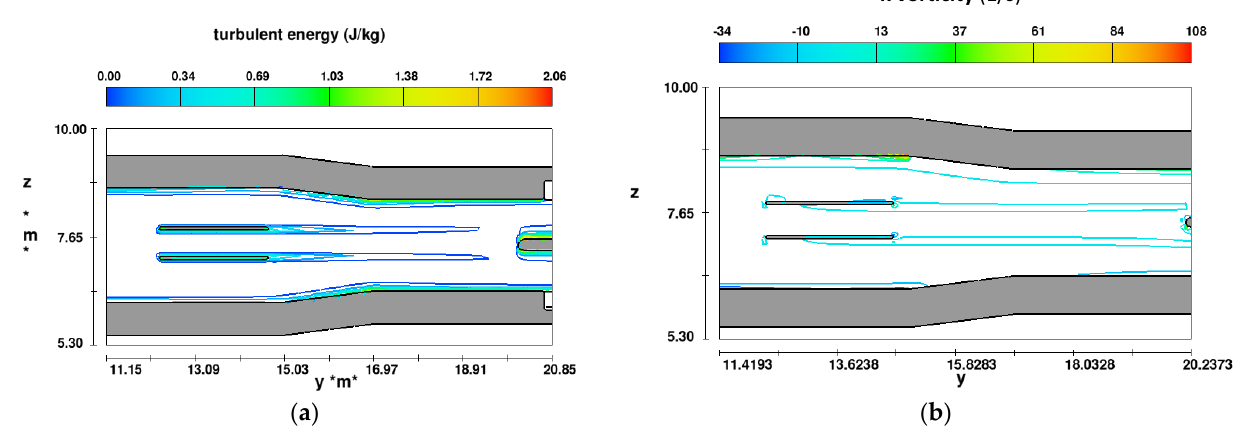
Figure 9. ( a ) sectional view of turbulent energy contours for the longitudinal distance between two valves = 3D; and ( b ) vorticity contours.